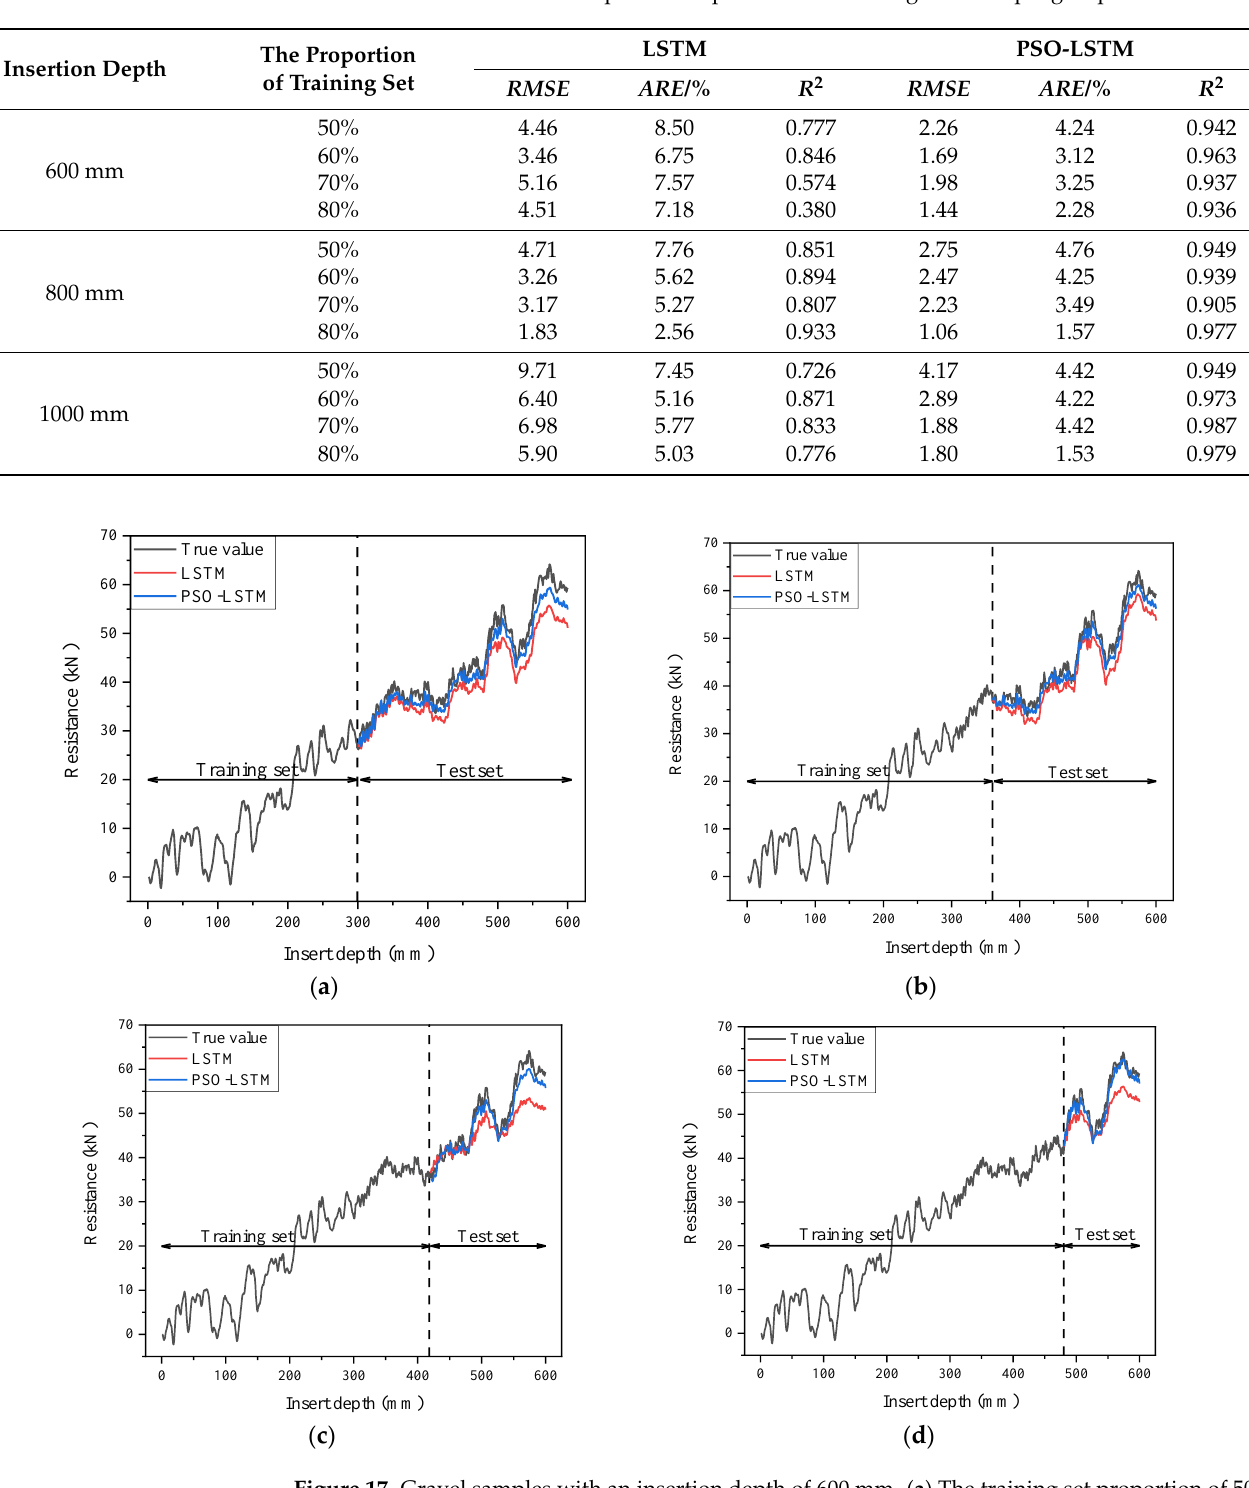
( d ) Figure 18. Gravel samples with an insertion depth of 800 mm. ( a ) The training set proportion of 50%; ( b ) The training set proportion of 60%; ( c ) The training set proportion of 70%; ( d ) The training set proportion of 80%.